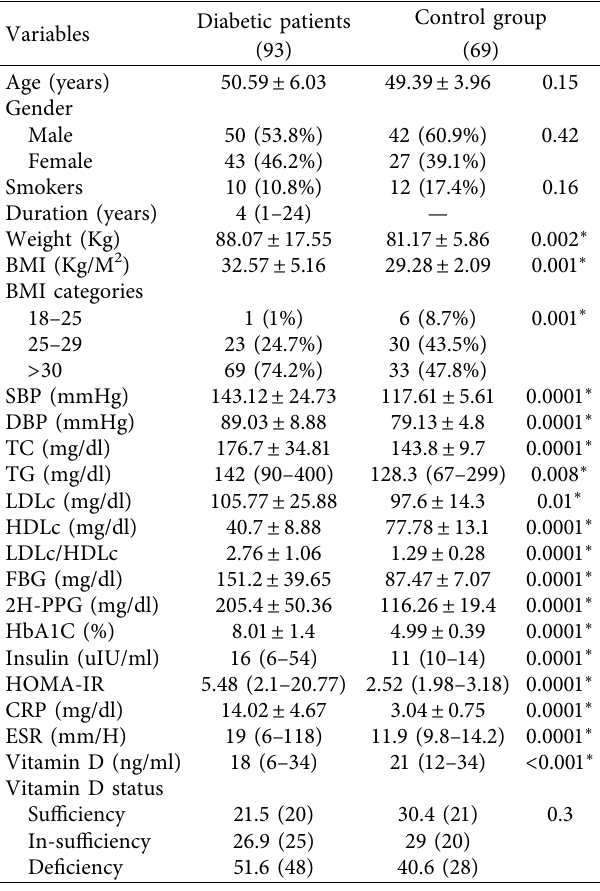
Table 1: Demographic, clinical and biochemical data among studied